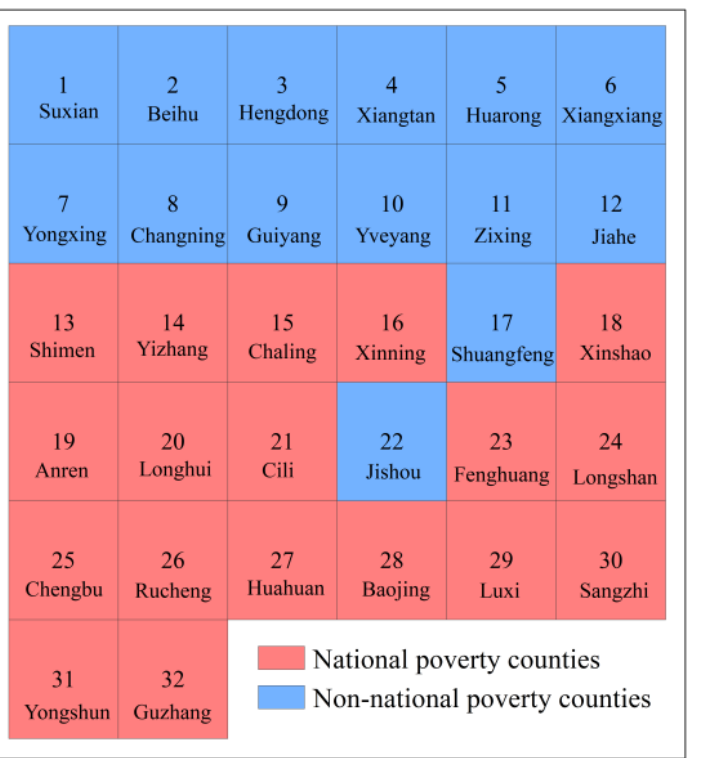
(1) Table 2. Localized, SDG 1 index weight for districts and counties. Localized SDG 1 Indicators for Districts and Counties Weight Indicator Attributes 1. Incidence of poverty 0.1379 — 2. Percentage of urban residents with minimum living allow-